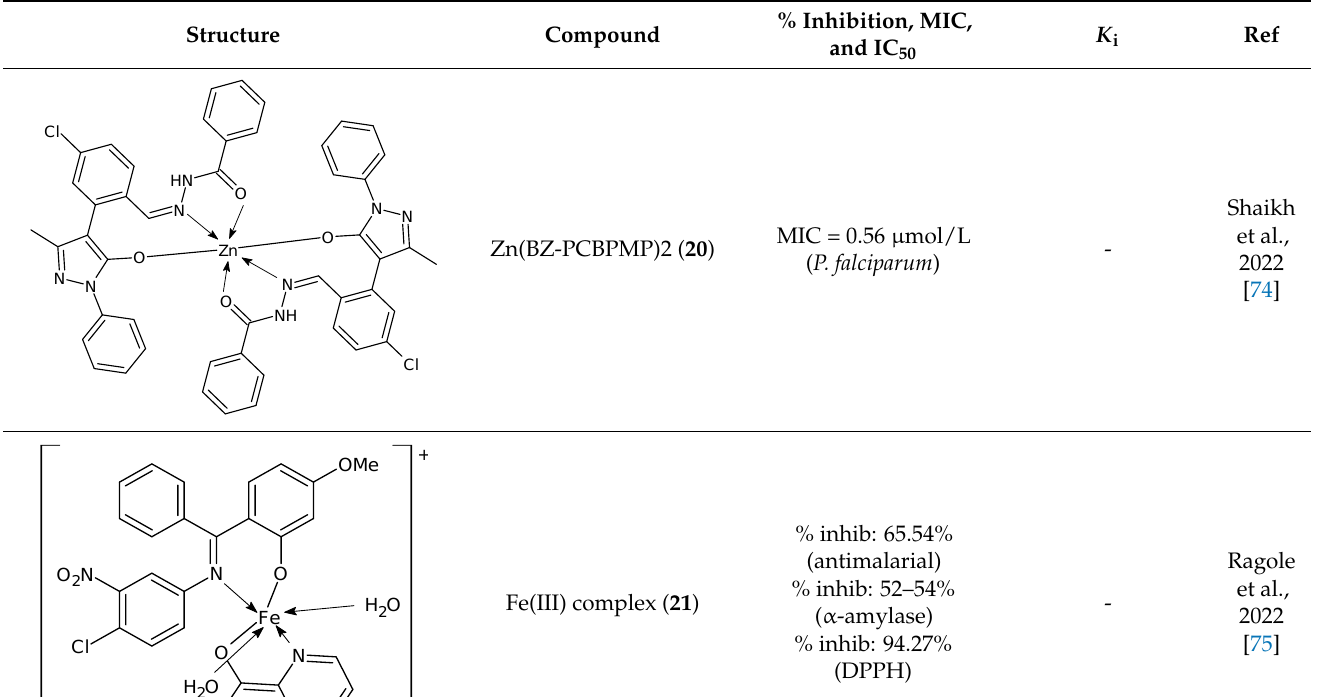
Table 2. SBs mononuclear metal complexes with antimalarial, antioxidant, antidiabetic, and anti- Alzheimer activities.